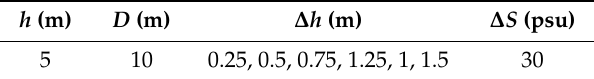
Figure 8. Definition sketch of a numerical sandy tank used for numerical analysis. Table 4. Numerical conditions.